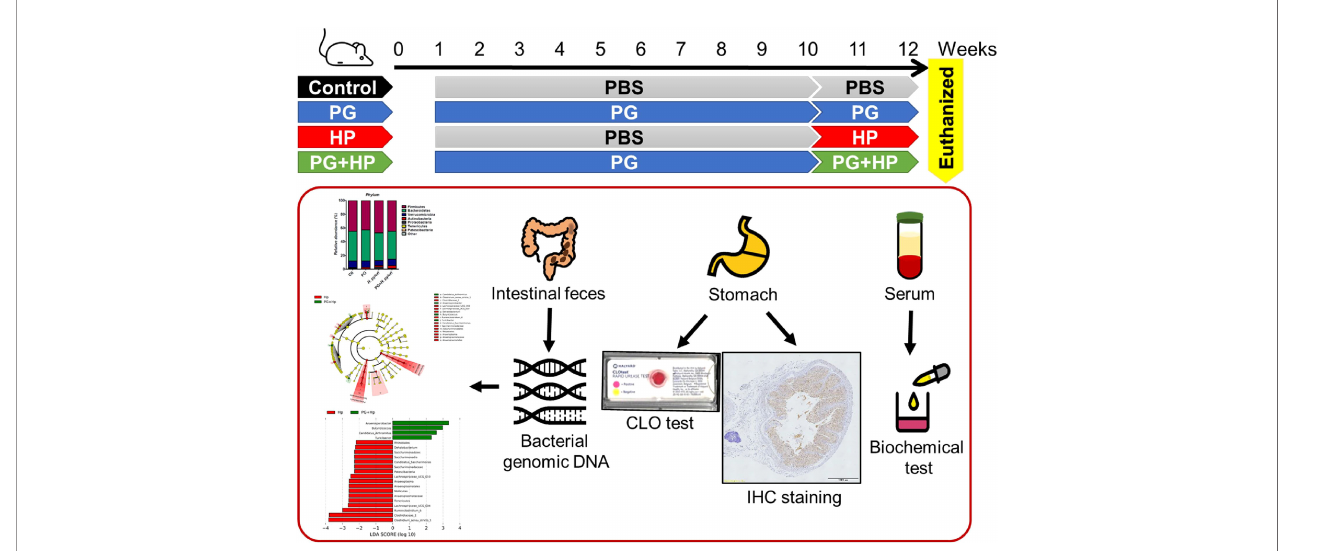
FIGURE 1 | Murine model for experimental studies. Mice were divided into four groups for the treatments with vehicle-control (PBS, n = 9), P. goldsteinii MTS01 (PG, n = 10), H. pylori (HP, n = 8), and P. goldsteinii MTS01 + H. pylori (n = 10). Mice were intragastrically administered P. goldsteinii MTS01 (2×10 8 CFU/100 m l) once daily for a total of nine weeks and continuously inoculated with P. goldsteinii MTS01 and H. pylori (1×10 9 CFU/100 m l) once daily for additional two weeks. Mice were euthanized and the samples of blood, stomach, and stool were prepared for further